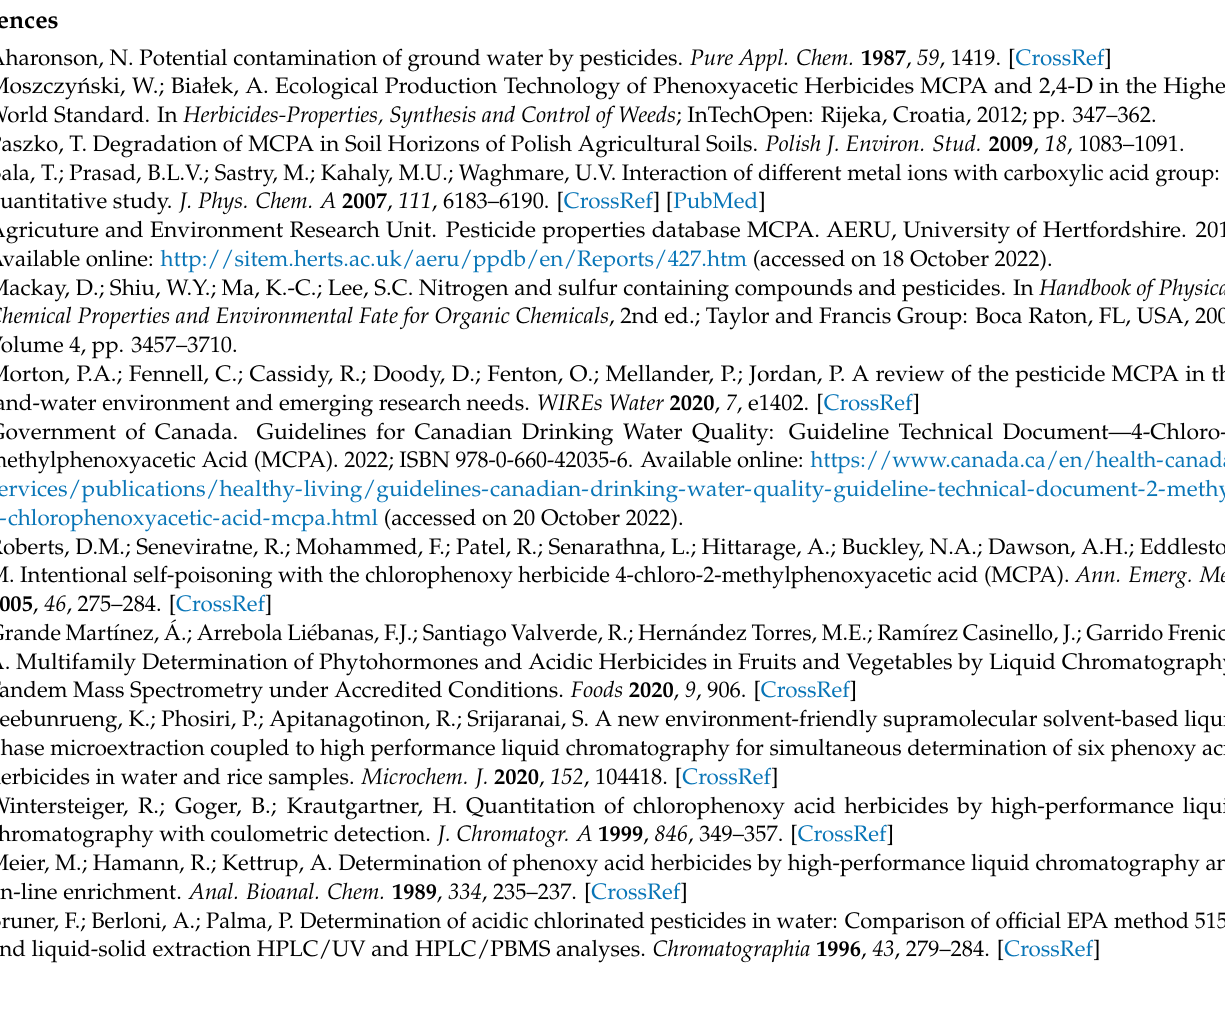
for potential acquisition; Figure S3: SEM images of (a) MCPA molecularly imprinted polymer and (b) not-imprinted polymer at the same magnification; Figure S4: Potentiometric response of the MIP- modified electrode in MCPA 0.5 µ mol L − 1 solution after the addition of bentazone of 0.5 µ mol L − 1 , 1.0 µ mol L − 1 and 2.5 µ mol L − 1